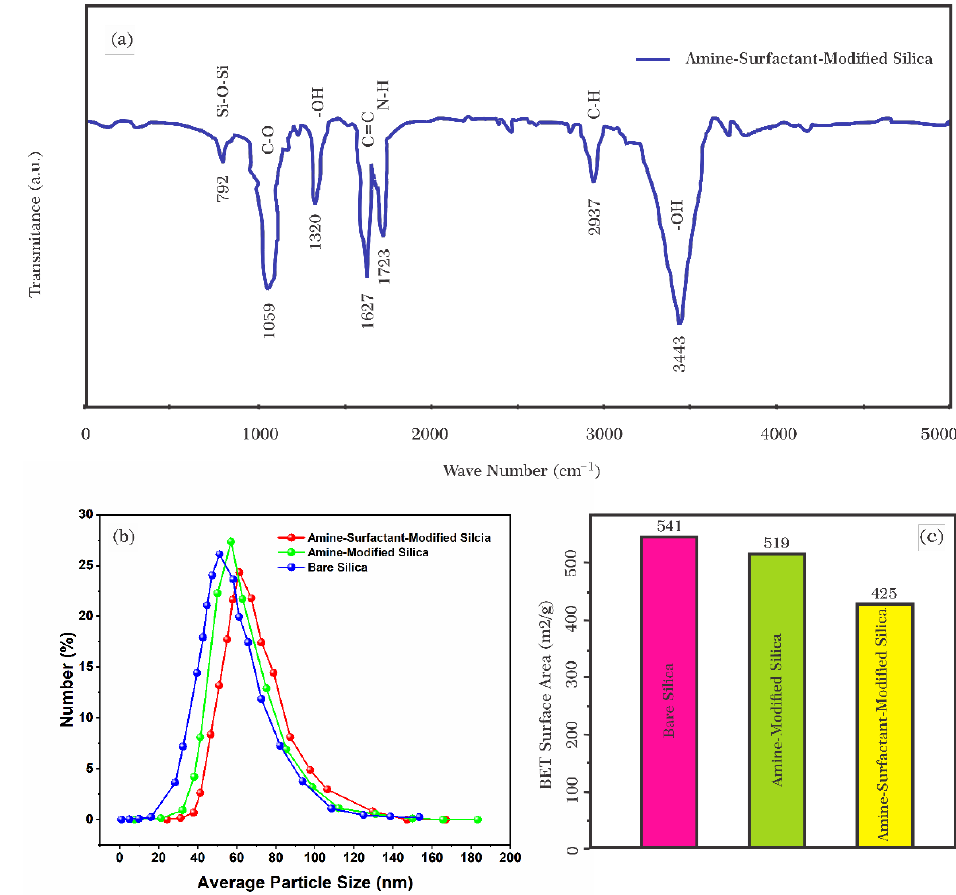
Figure 8. ( a ) FT-IR spectrum of amine-surfactant-modified SiO 2 nanoparticles, ( b ) particle size distribution and ( c ) BET surface area of bare, amine-treated, and amine-surfactant-treated SiO 2 nano- particles.